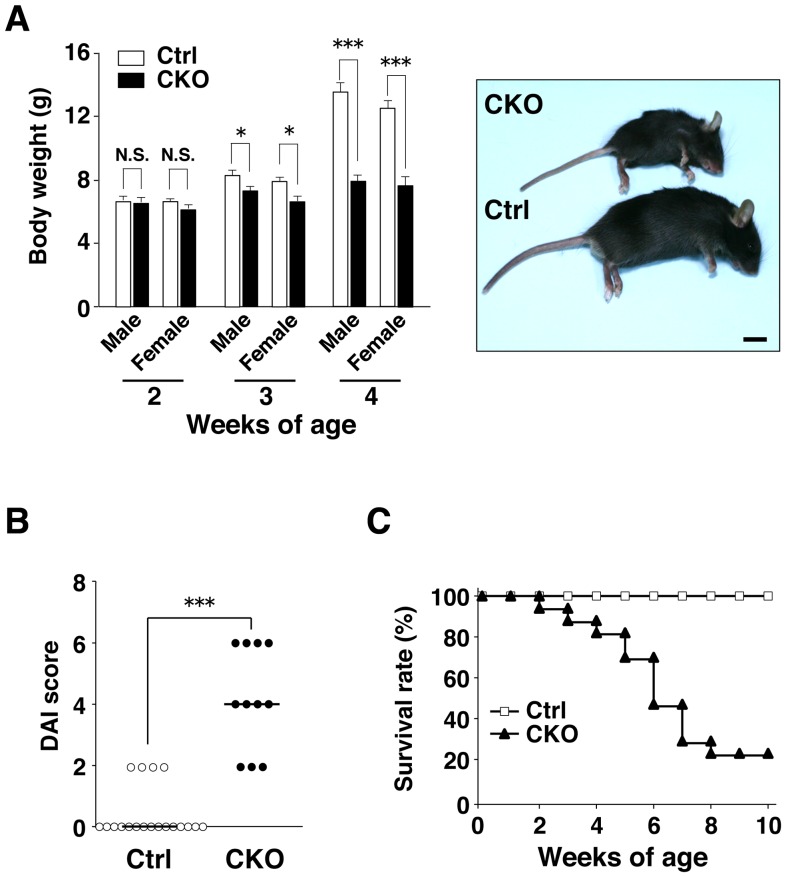
Shp2 CKO mice develop severe colitis.
A: Body weight of 2-, 3-, or 4-week-old control (male, n = 23, 26, and 27, respectively; female, n = 22, 24, and 22, respectively) or Shp2 CKO (male, n = 17, 20, and 16, respectively; female, n = 15, 15, and 13, respectively) mice is shown in the left panel. Data are means ± SE. *P<0.05, ***P<0.0001 (Welch's t test). N.S., not significant. Representative photographs of control and Shp2 CKO mice at 5 weeks of age are shown in the right panel. Scale bar, 1 cm. B: Disease activity index (DAI) for colitis in control (n = 19) and Shp2 CKO (n = 11) mice at 4 to 5 weeks of age. Bars indicate median scores. ***P<0.0001 (Wilcoxon rank-sum test). C: Survival rates of control (n = 19) and Shp2 CKO (n = 17) mice.